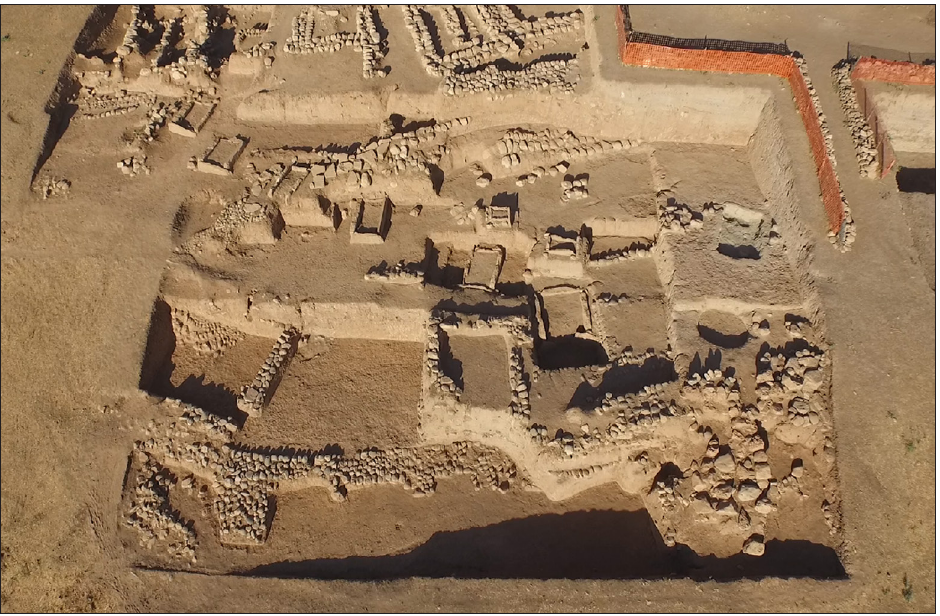
Figure 1: Overview of the EBA 1 Cemetery showing cist graves with retainer burial and pit graves with mass burial. North is to the right of the image. Figure: Ba